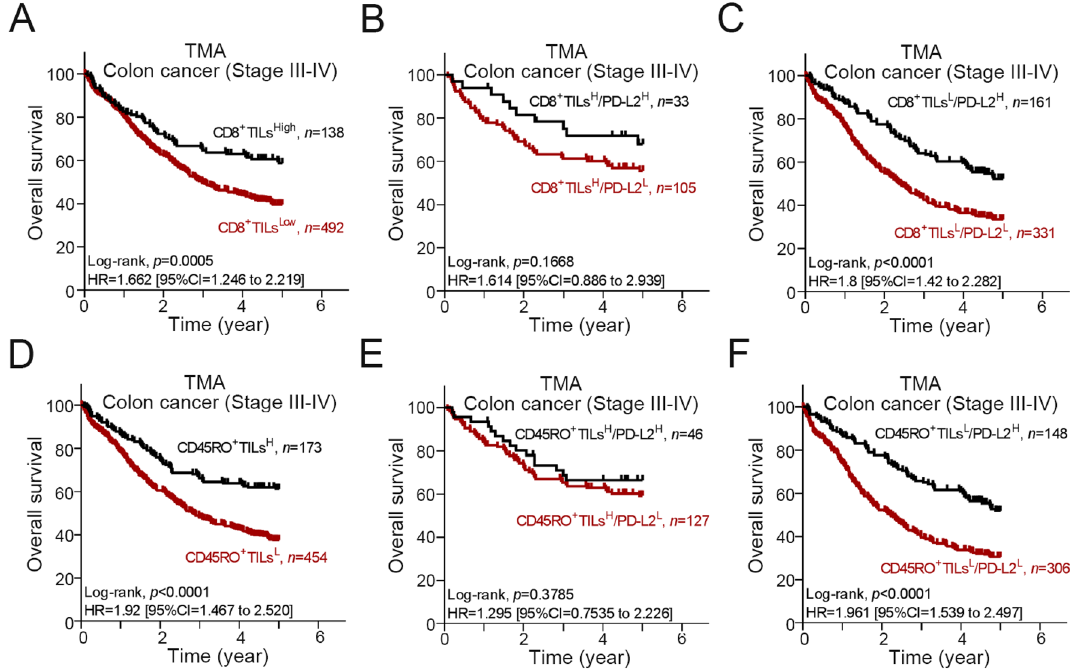
Figure 4. The association of tumor PD-L2 level and CD8 + TIL and CD45RO + TIL density with 5-year OS in advanced stage colon carcinoma. ( A ) Advanced stage colon carcinoma patients with high infiltration of intratumoral CD8 + TIL within the TME had a better 5-year OS (n = 630, p = 0.0005). ( B ) The tumor PD-L2 level was not associated with 5-year OS in patients with a high density of CD8 + TILs within the TME ( n = 138, p = 0.167). ( C ) The tumor PD-L2 level was associated with 5-year OS in patients with a low density of CD8 + TILs within the TME ( n = 492, p < 0.001). ( D ) Advanced stage colon carcinoma patients with a high density of CD45RO + TILs within the TME had a better 5-year OS (n = 627, p < 0.001). ( E ) The tumor PD-L2 level was not associated with 5-year OS in patients with a high density of CD45RO + TILs within the TME ( n = 173, p = 0.3785). ( F ) The tumor PD-L2 level was associated with 5-year OS in patients with a low density of CD45RO + TILs within the TME ( n = 454, p <